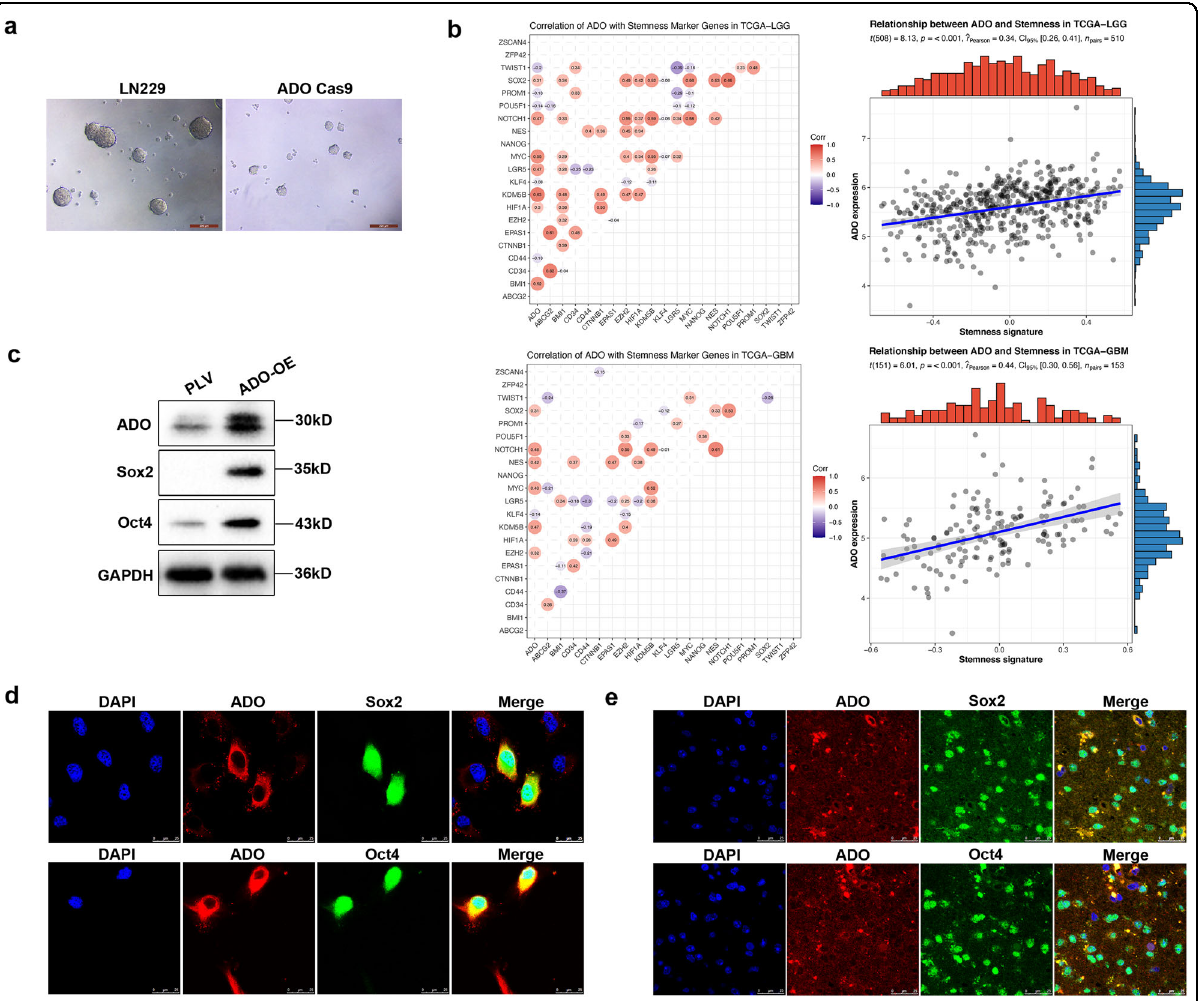
Fig. 3 ADO is upregulated in glioblastoma stem-like cells. a Sphere formation derived from LN229 ADO-Cas9 and control cells. Scale bars = 200 μ m. b Analysis of correlations between ADO and a series of stemness markers in two TCGA cohorts (TCGA-LGG and TCGA-GBM), which were retrieved from GDC data portal (https://portal.gdc.cancer.gov/). c , d Sox2 and Oct4 expression was detected by western blotting and immuno fl uorescence under confocal fl uorescence microscopy in U118 and ADO-OE U118 cells, respectively. Scale bars = 25 μ m. e Sox2, Oct4, and ADO co-staining in glioma patients sections with high levels of ADO, Sox2, and Oct4 were located within the nucleus. Scale bars = 25 μ m. All results are representative of three independent